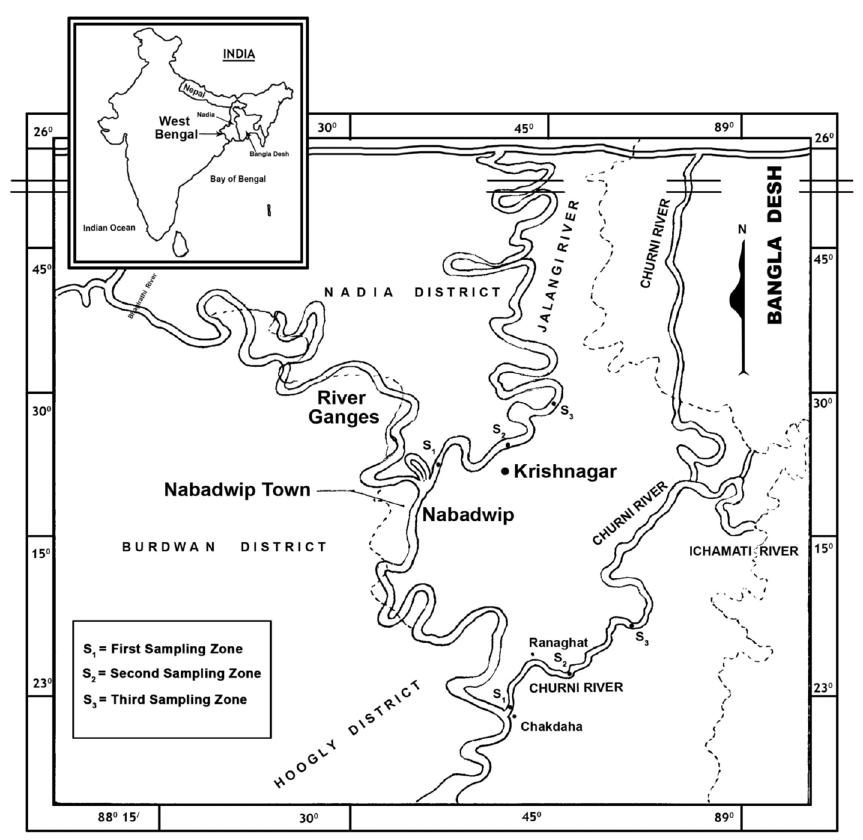
Fig. 1. Geographical location of the two studied